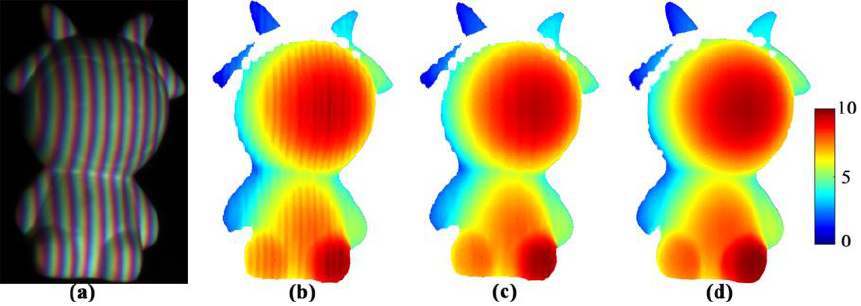
Figure 9. Results of a white sculpture: ( a ) captured image of the sculpture; ( b ) the absolute phase without corrections; ( c ) the absolute phase obtained using the first step of the proposed method; and ( d ) the absolute phase optimized with the whole proposed method. Unit: rad.